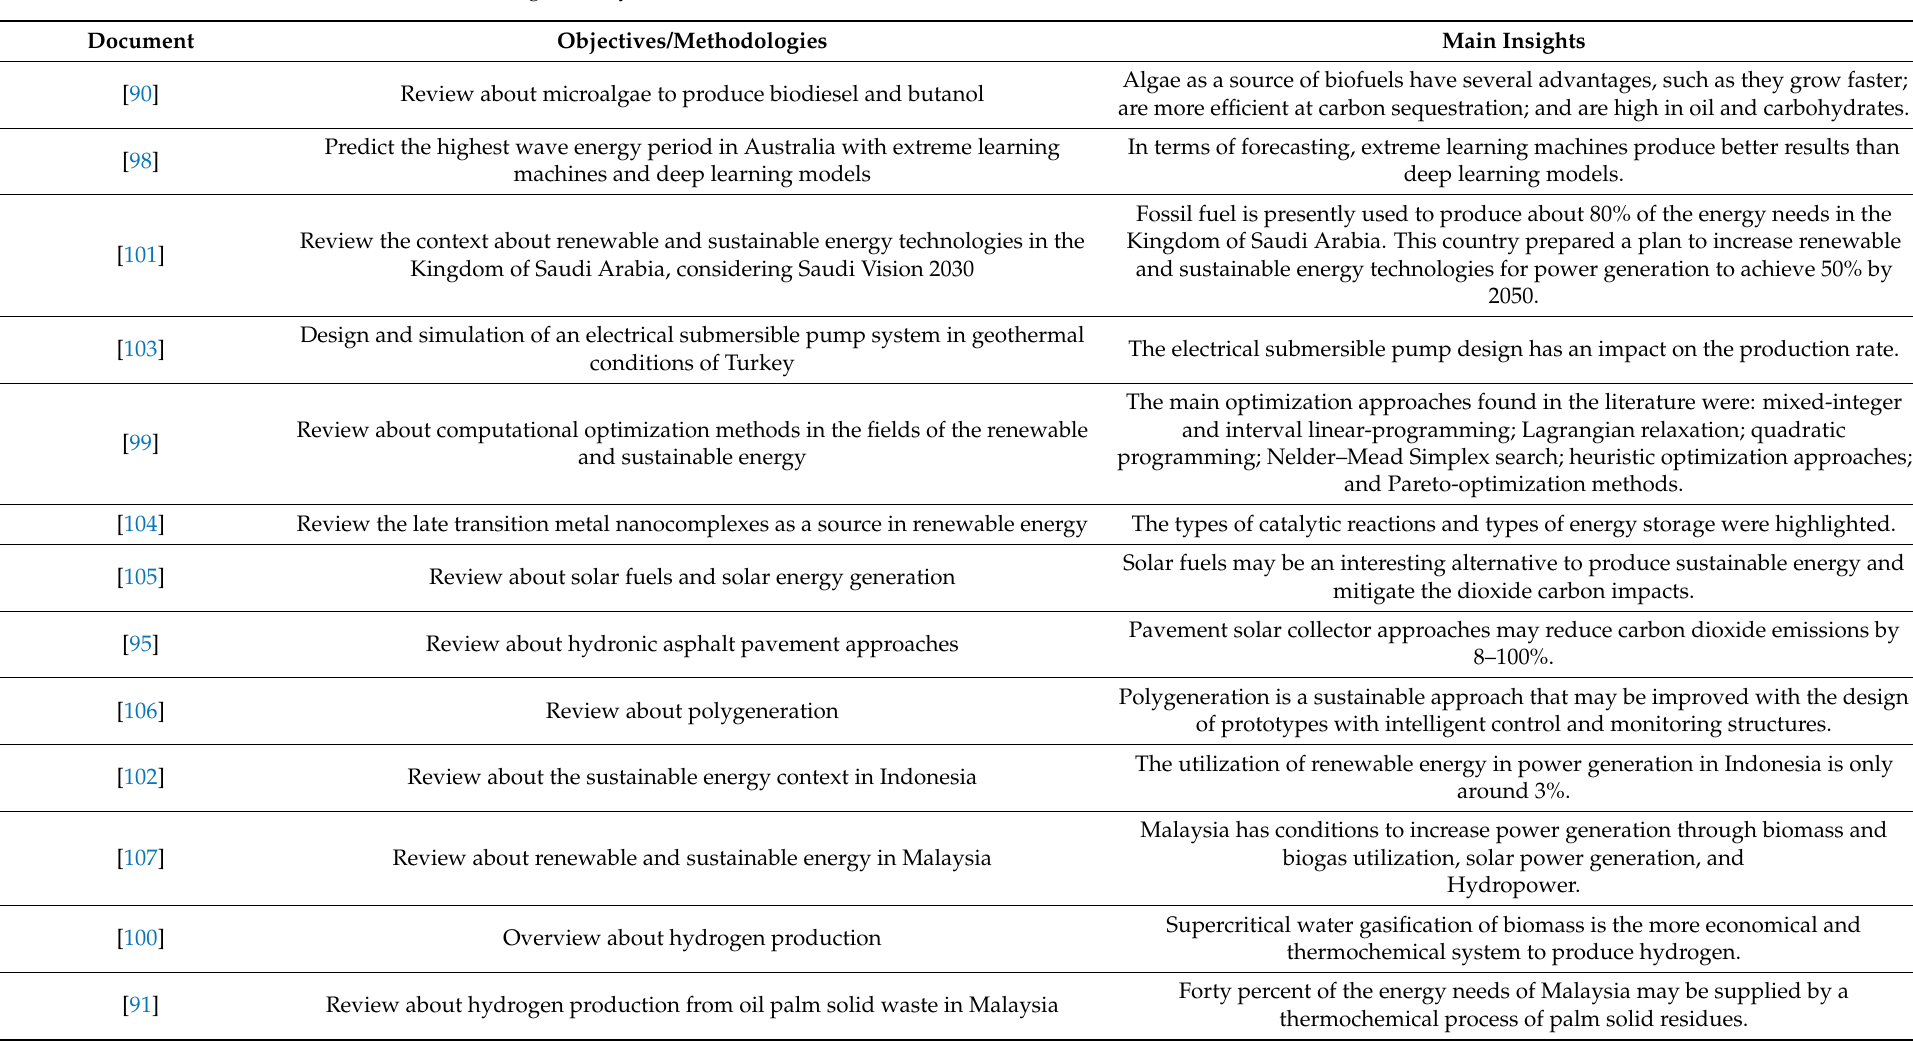
Table 8. Main findings from systematic